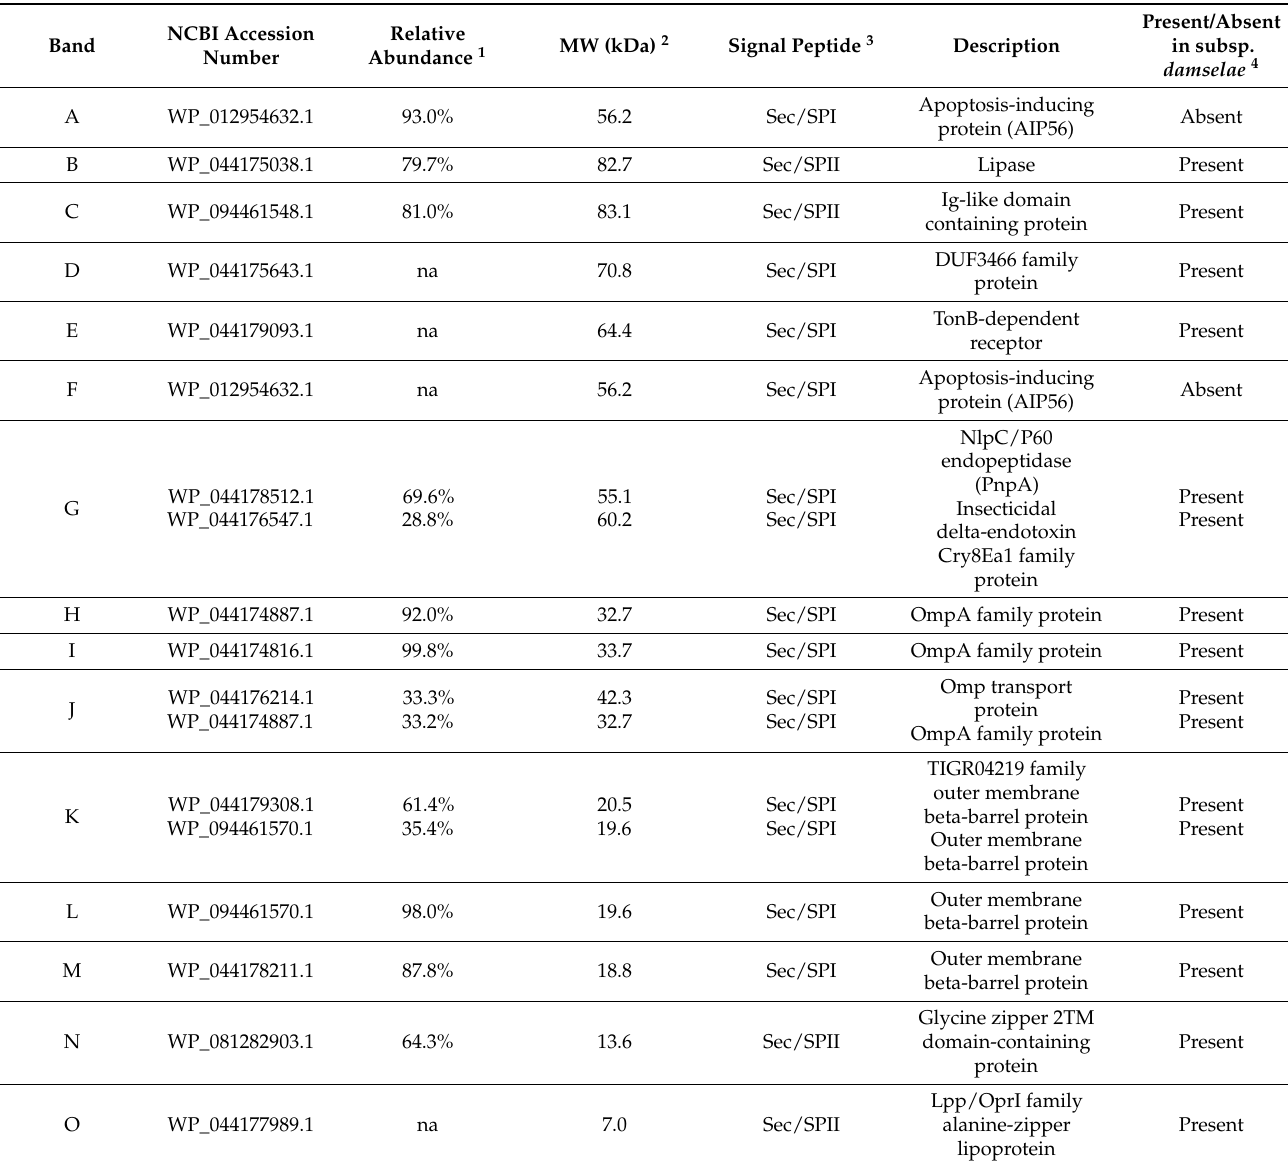
Table 1. Identity of the most abundant proteins of crude MT415 OMVs. Bands A–O correspond to the gel bands in Figure 2. Bands D–F were identified by PMF/MALDI-TOF and the remaining bands by